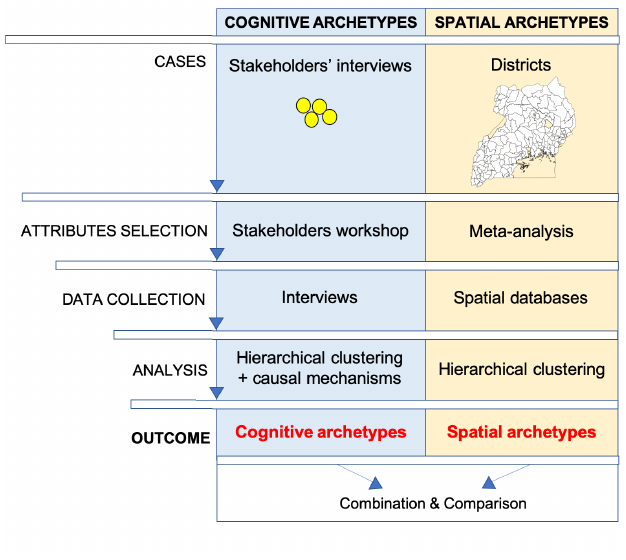
Fig. 1. Analytical framework showing the analytical steps and methods used to delineate cognitive and spatial